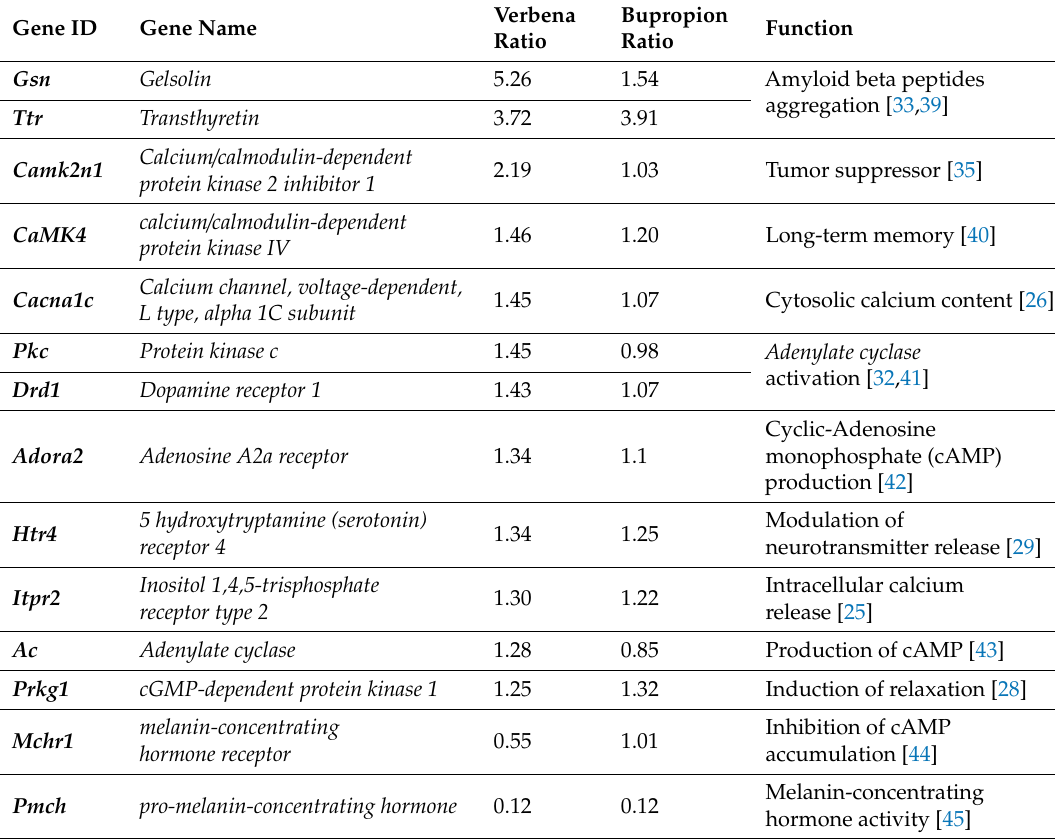
Table 1. Genes regulated by VEE involved in induction of relaxation and the activation of energy metabolism. The ratios were calculated using the data of mice receiving water as